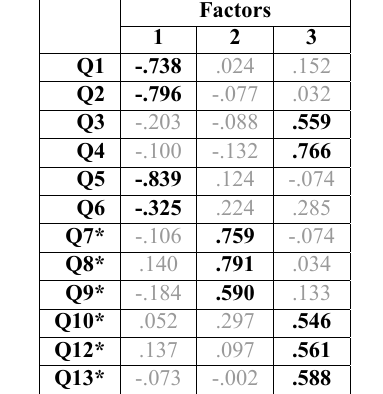
Table 5. Standardized loadings matrix for the adapted SEQ in the Exploratory Factor